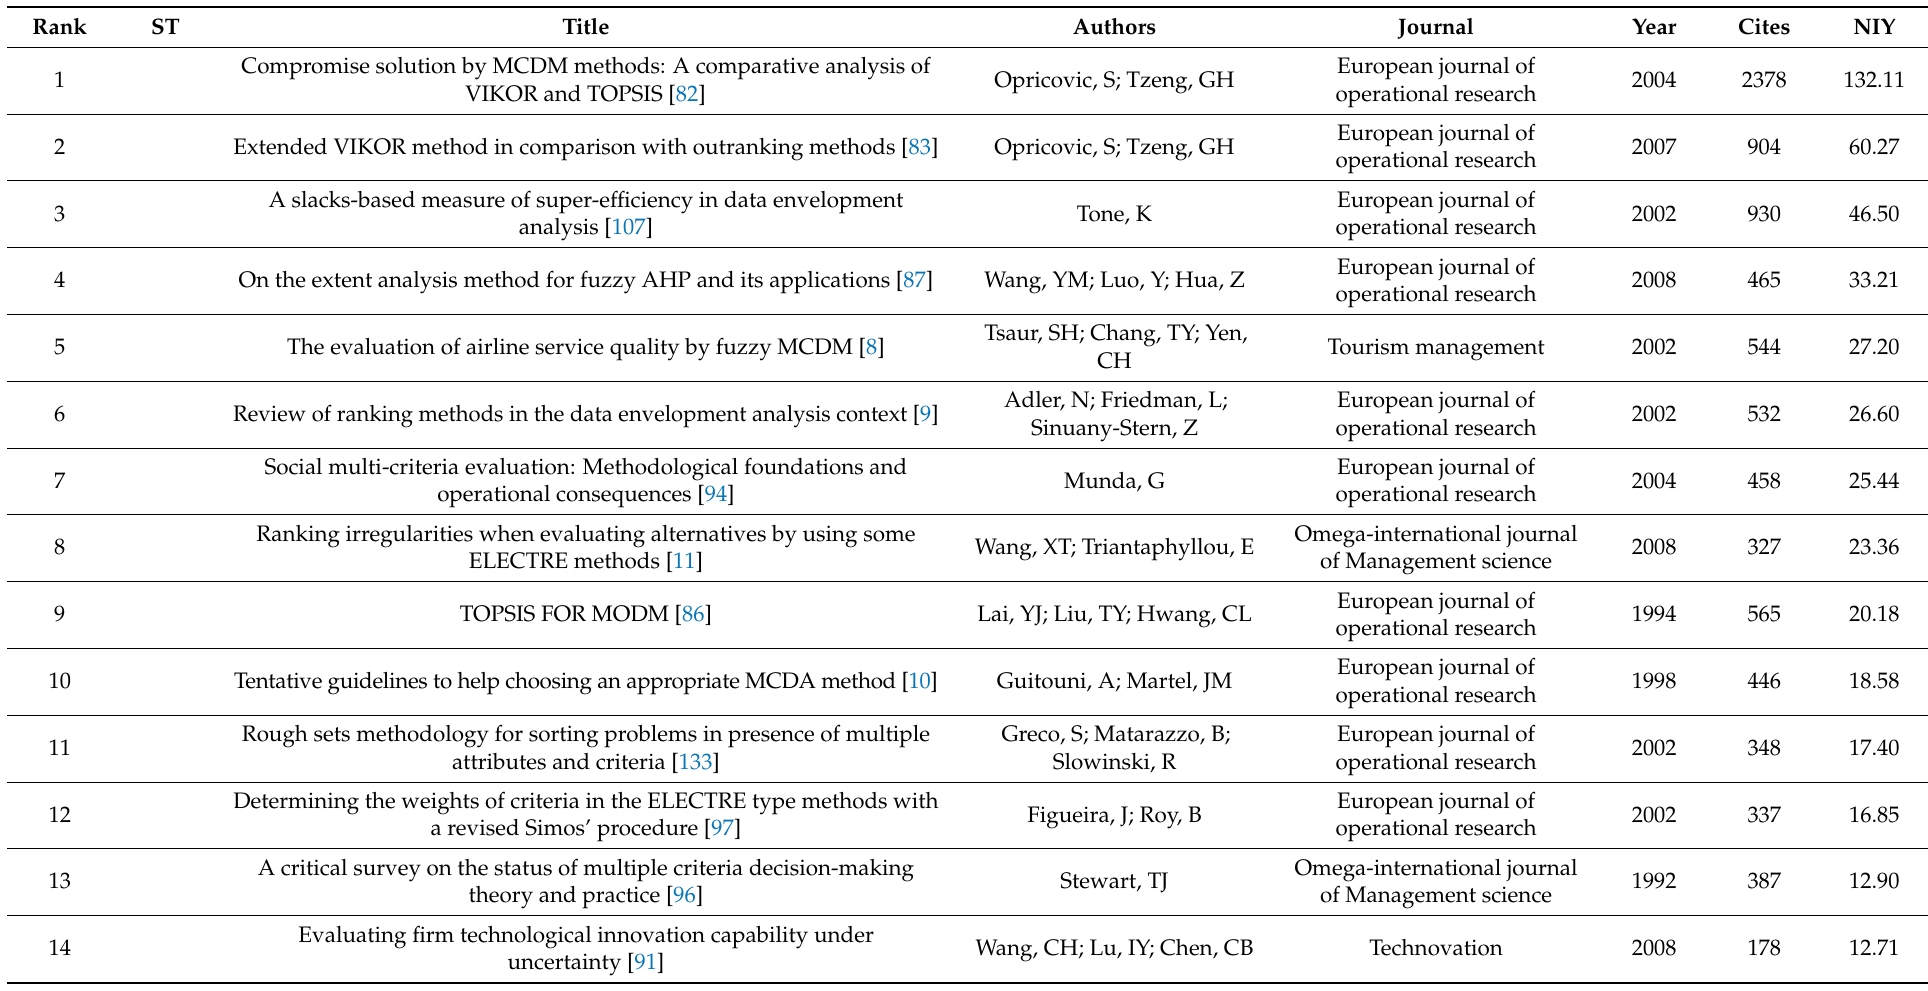
Table A3. Top 25 articles by NIY. Subperiod 1